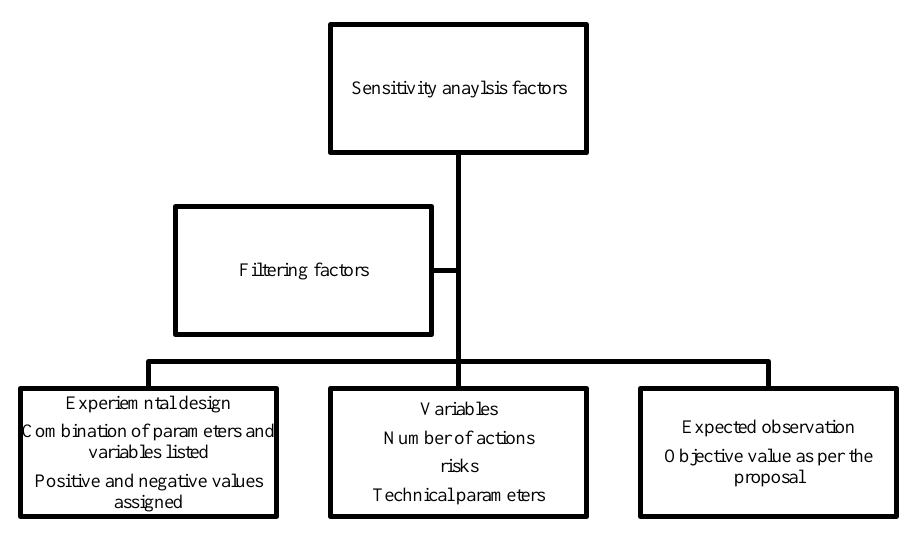
Fig. 1. Sensitivity analysis